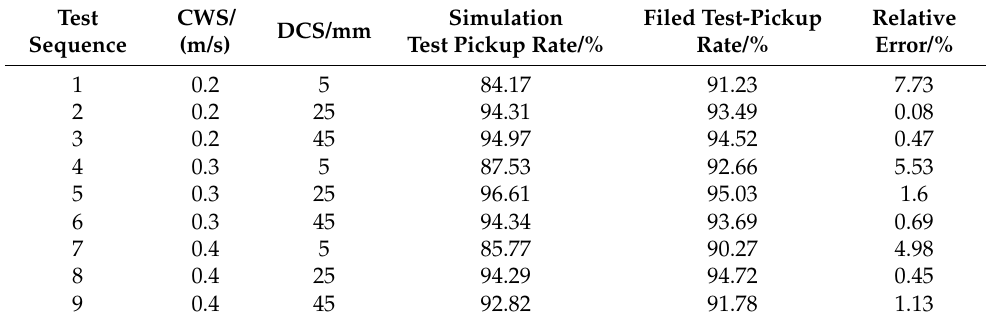
Table 2. Test Table 2. Test results.